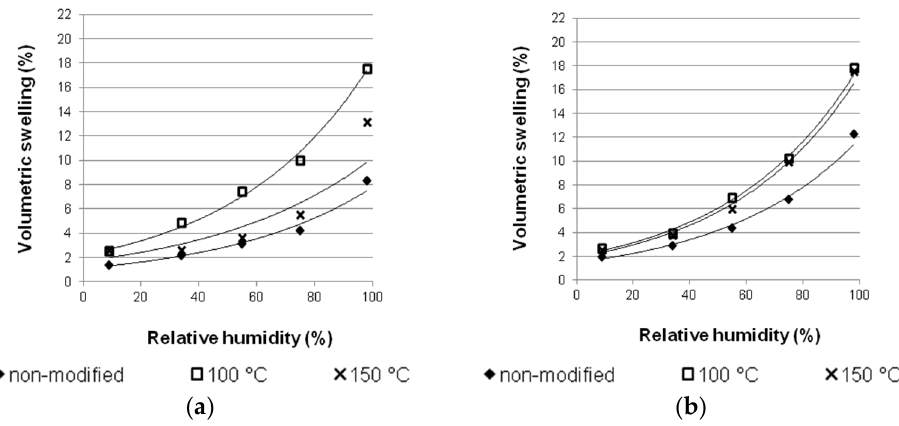
Figure 7. Volumetric swelling of ( a ) iroko and ( b ) tauari wood before and after thermo-mechanical modification, depending on relative humidity of air. Table 7. Fitted curves predicting the swelling of non-densified and densified iroko and tauari wood at various relative humidity (RH) values.